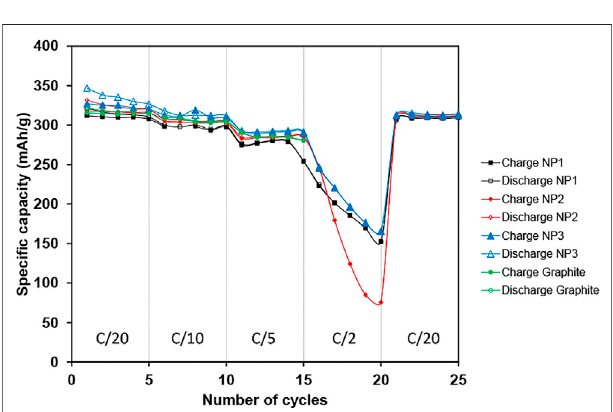
FIGURE6| Cyclingperformance(chargeanddischargecapacityversus cyclenumber)ofgraphite, NP1,NP2,andNP3 electrodesat differentC-rates. Note: 10 wt% of GNPs is used in graphene-based electrodes; the total active material is 94.5 wt%.